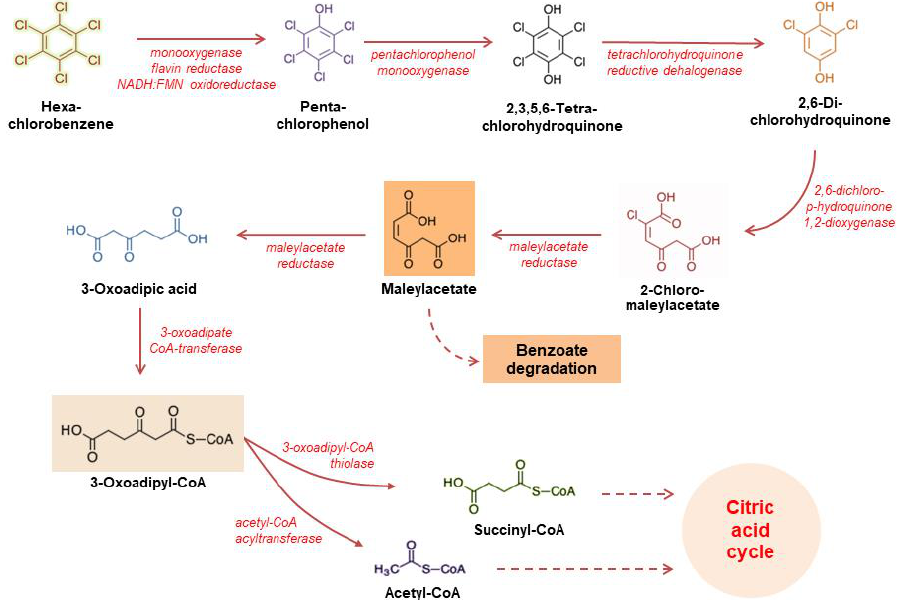
Figure 3. A hypothetical scheme of the hexachlorobenzene decomposition by Comamonas testosteroni bacterial strains (it was generated according to the following literature data [37,45]).